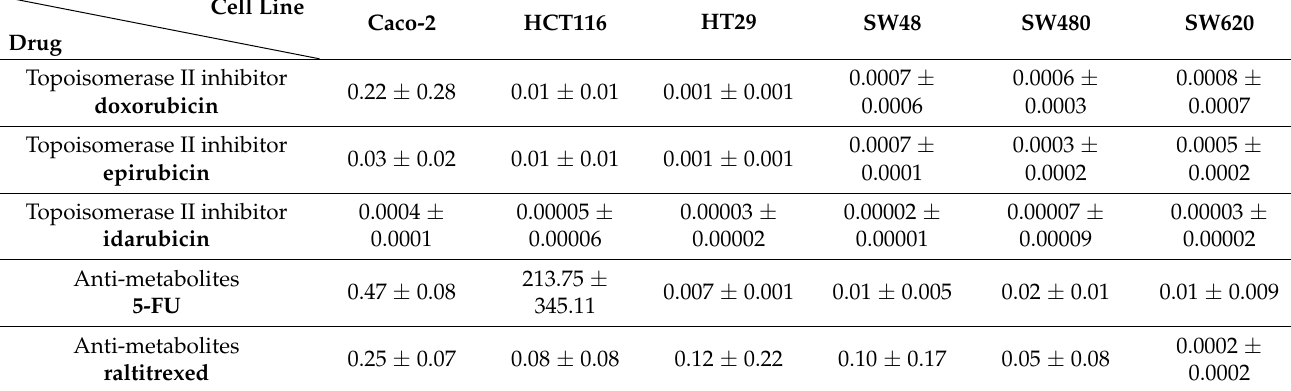
Table 1. IC 50 values (mean ± standard deviation) obtained for 6 colorectal cancer cell lines and 12 antitumoral agents. The bold is to underline the name of the drug, distinguish from the family of the drug. Cell Drug